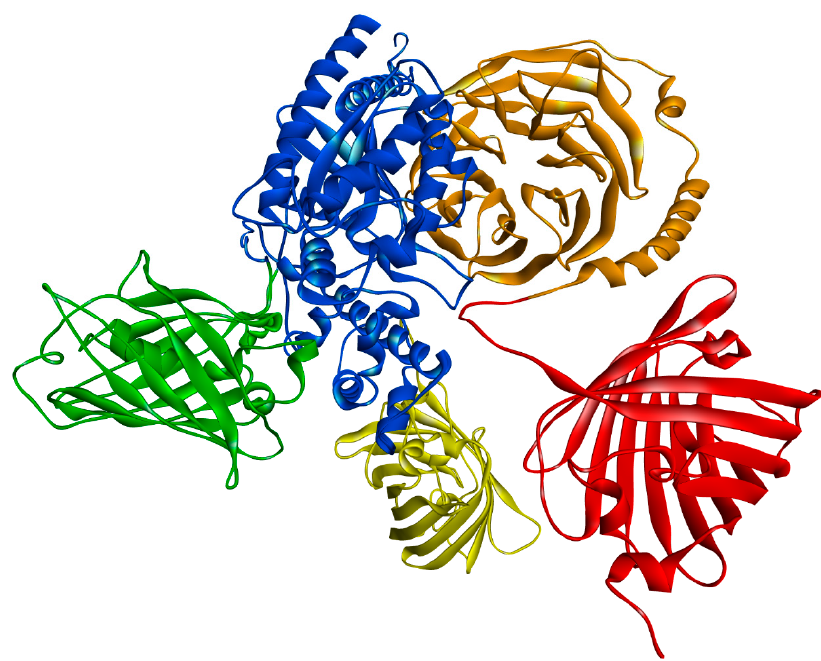
Figure 3. Localization of FP in the structures of G α s and G α i 3 . The molecular models of Citrine (green)–G α s (blue), Citrine (yellow)–G α i 3 (concealed), and mCherry (red)–G β 1 (orange) were generated with Chimera 1.13.1 [37] based on the structures of FP, G α s, G α i 3 , and G β 1 (PDB id.: 1xa9, 6crk, 2ode, 6b3j, respectively). The models generated for fusion proteins were visually inspected, and the best-scored structures with suitable loops were chosen. The structure of a heterotrimeric complex of the investigated fusion proteins was recreated with the Discovery Studio software, version 4.0 (BIOvIA, D. S., San Diego, CA, USA,